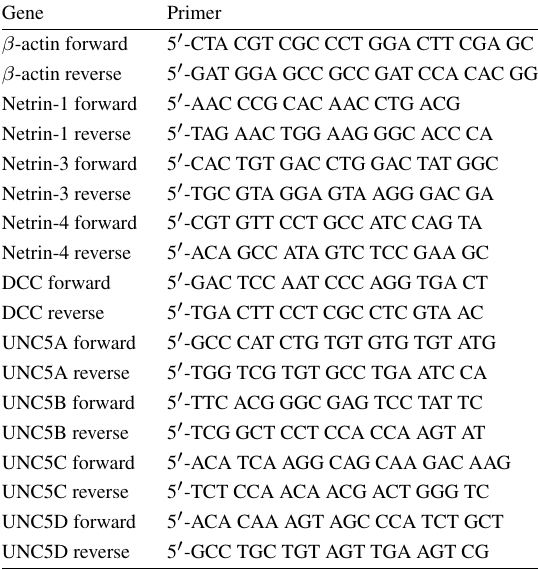
Primer sequences for primers used in RT-PCR